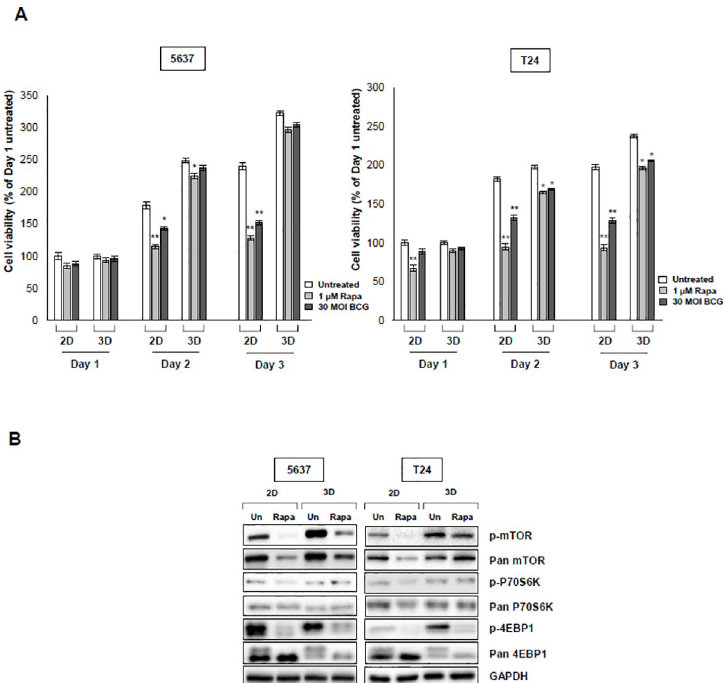
Fig 4. Drug treatment of bladder cancer cells in 2D and 3D environments. (A) Effect of treatment with rapamycin (inhibitor of mTOR) and Bacillus Calmette-Gue´rin (BCG) on viability of bladder cancer cells. Cells were treated with indicated concentrations of rapamycin (1 μ M, BCG, 30 MOI) for 1, 2, and 3 days. Absorbance was measured at 540 nm and cell viability was determined by the MTT assay. � p < 0 . 05 , �� p < 0 . 01 , ratios were normalized to each untreated group. Data are the mean ± SEM (n = 6). (B) Western blot analysis of 5637 and T24 bladder cancer cells cultured in 2D and 3D compared the expression of mTOR-mediated p70s6K and 4E-BP1 signal pathways. Cells were treated with rapamycin (1 μ M) for 24 h and then the cells were lysed. Western blotting results showed a reduced level of expression in cells in the 2D environment due to treatment with rapamycin. GAPDH was used as a loading control. A representative result from three experiments is